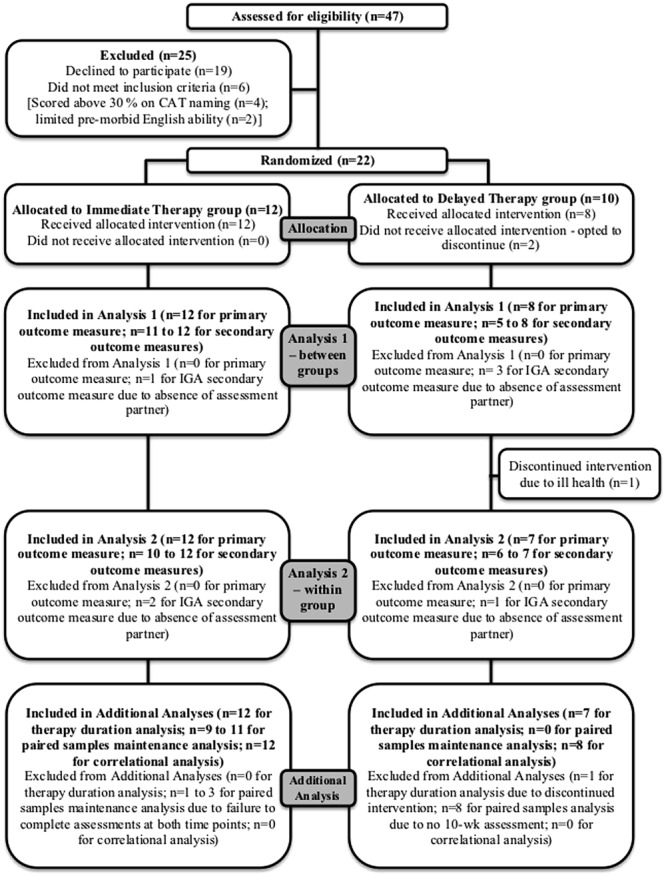
CONSORT diagram showing participants’ progression through the study.